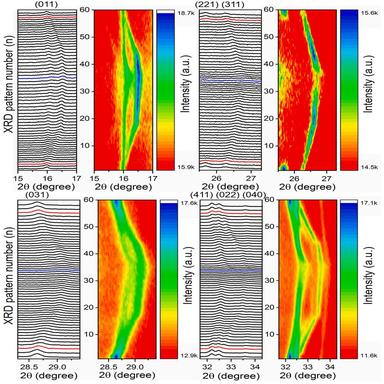
In situ XRD patterns of KVPF@C-MC2 electrode collected during the first cycle in KVPF@C-MC2//K half-cell.